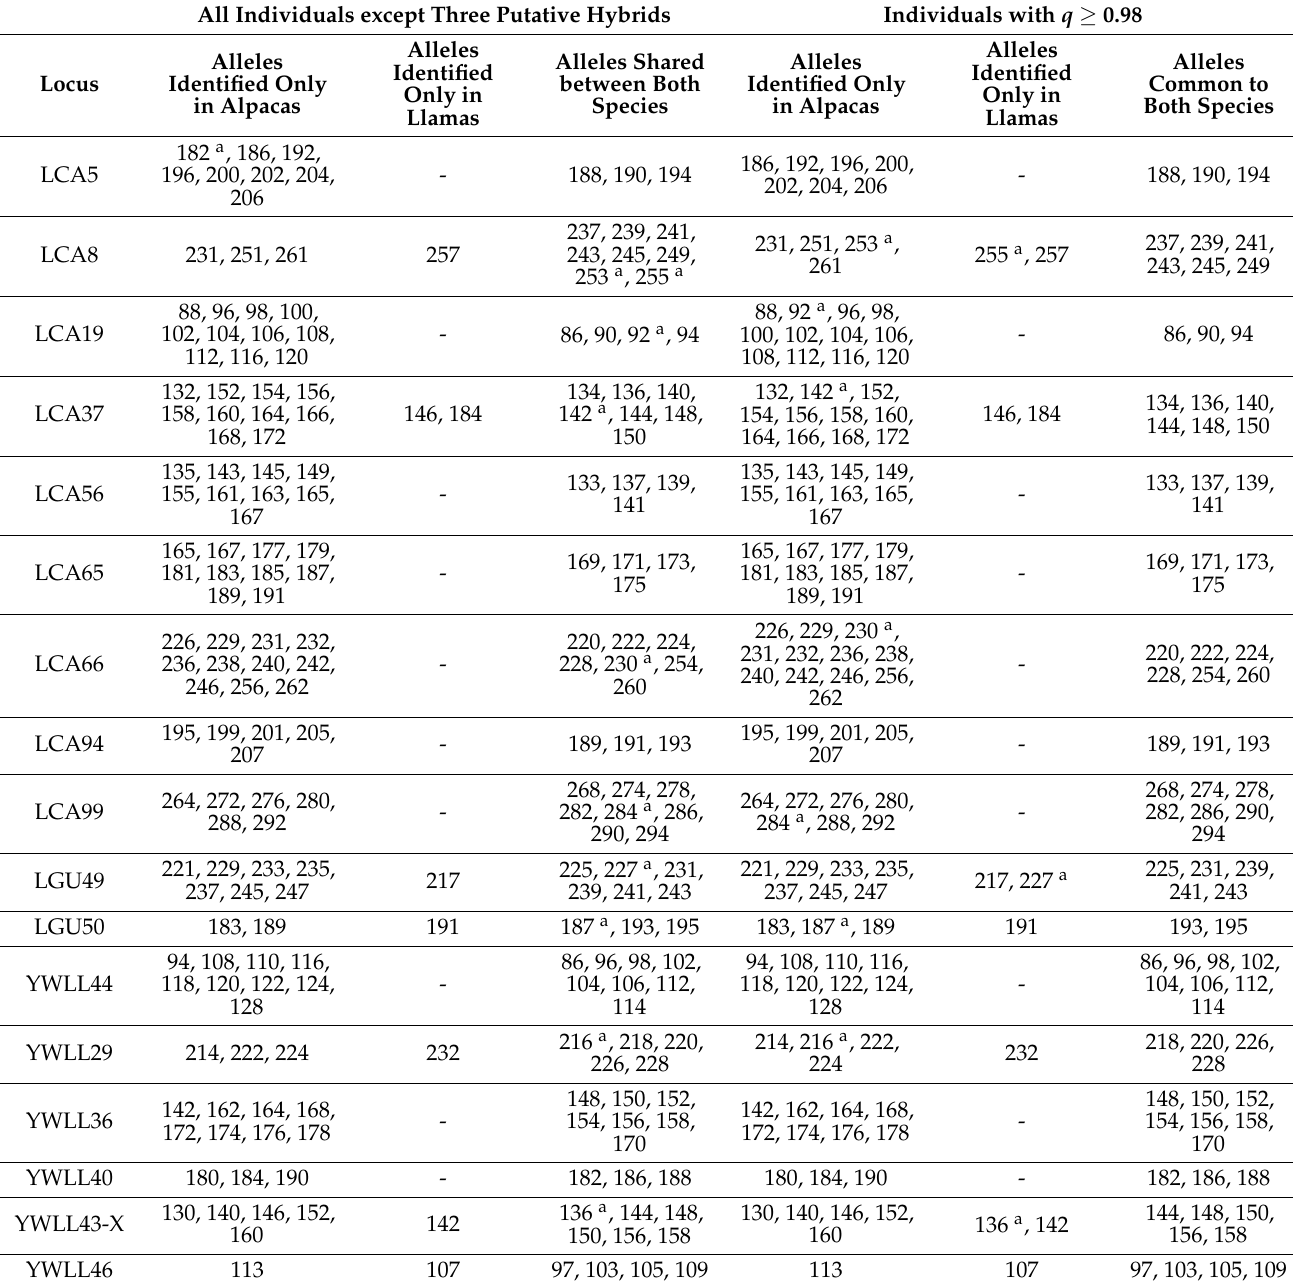
Table 4. Alleles private to alpacas and llamas and shared alleles across the 17 microsatellite loci. Alleles with a were reclassified in two independent analyzes in the GENEPOP. All Individuals except Three Putative Hybrids Individuals with q ≥